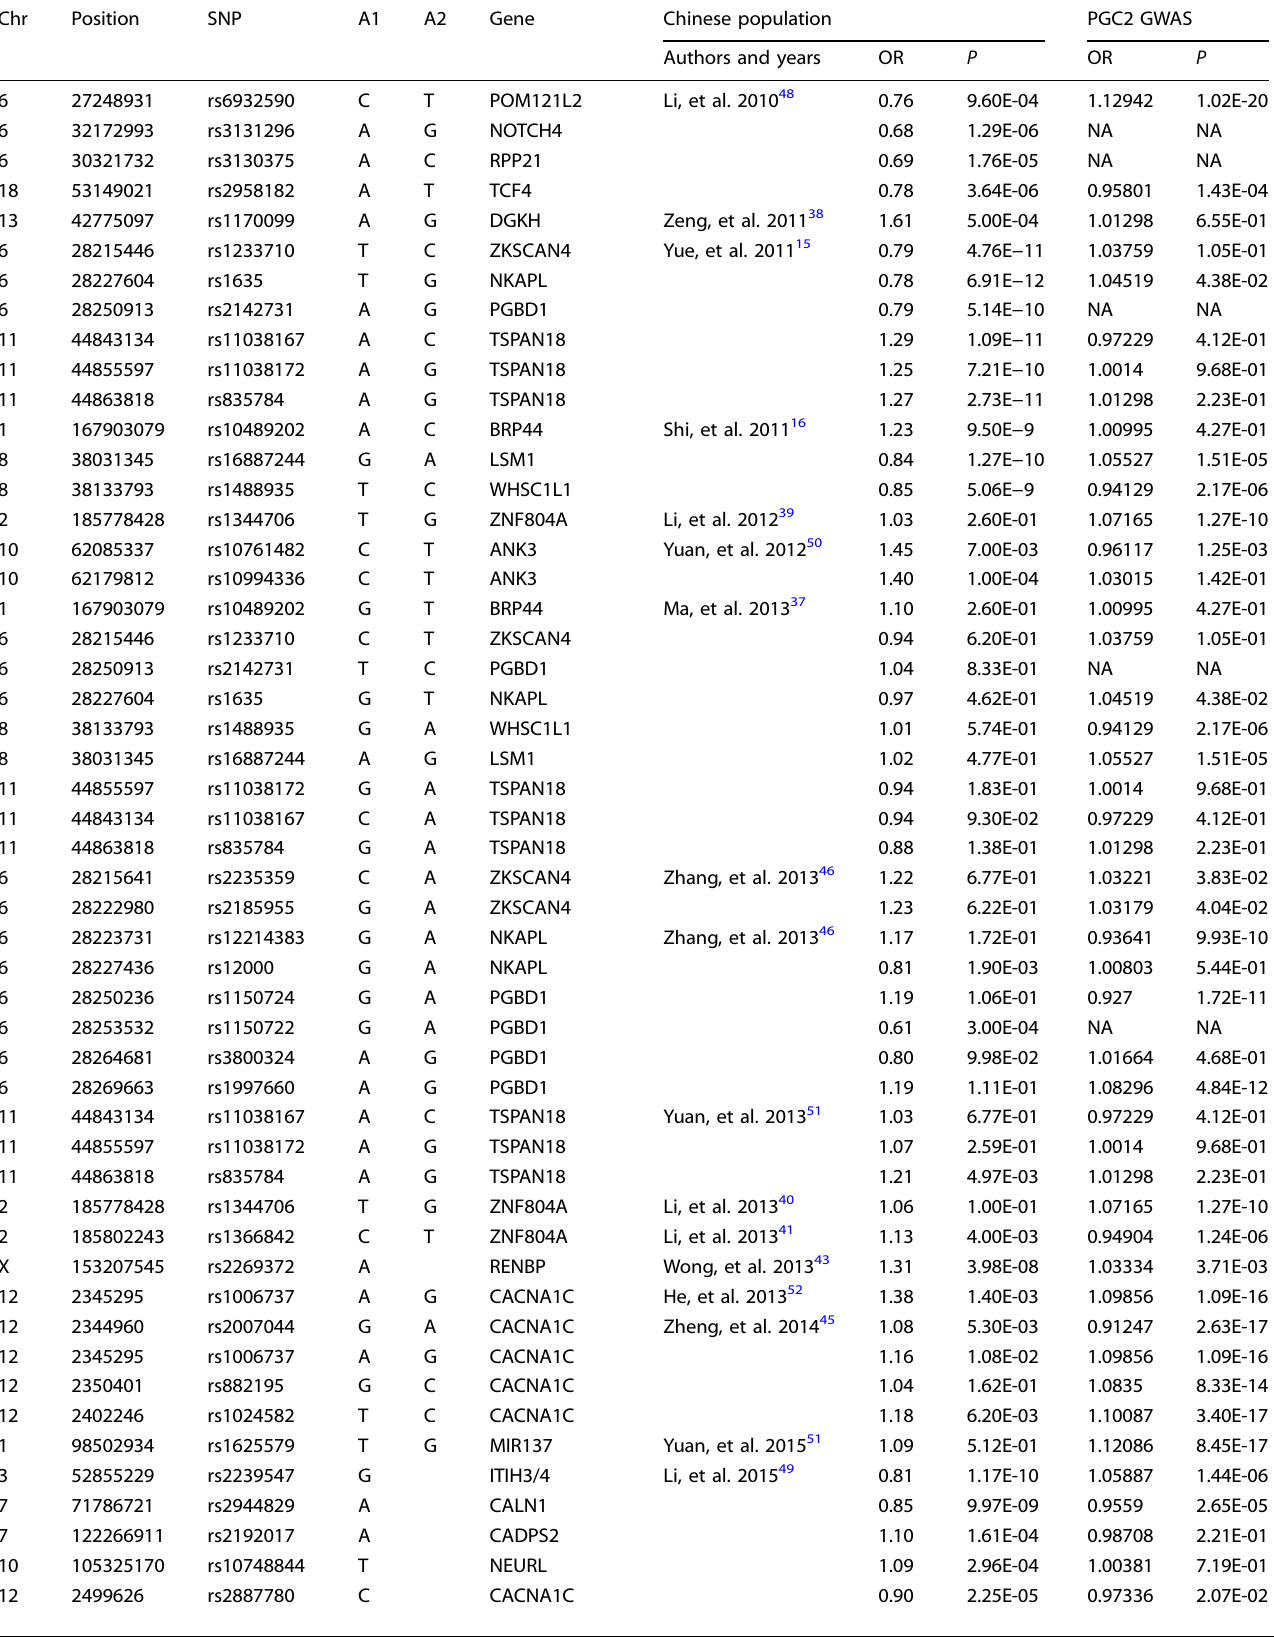
Table 3. Comparison of single-marker association results of schizophrenia in Chinese population and PGC2 sample